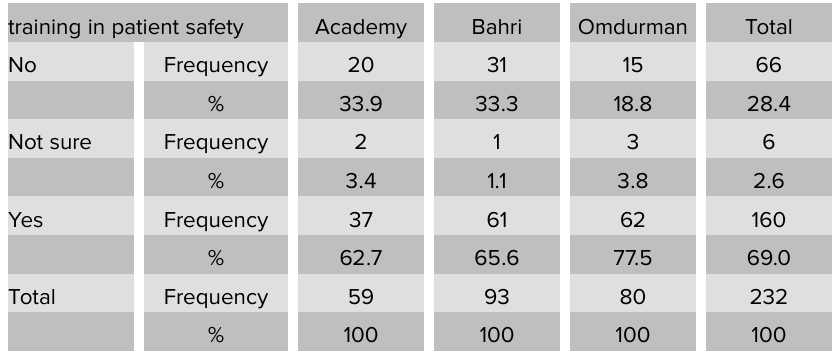
training in patient